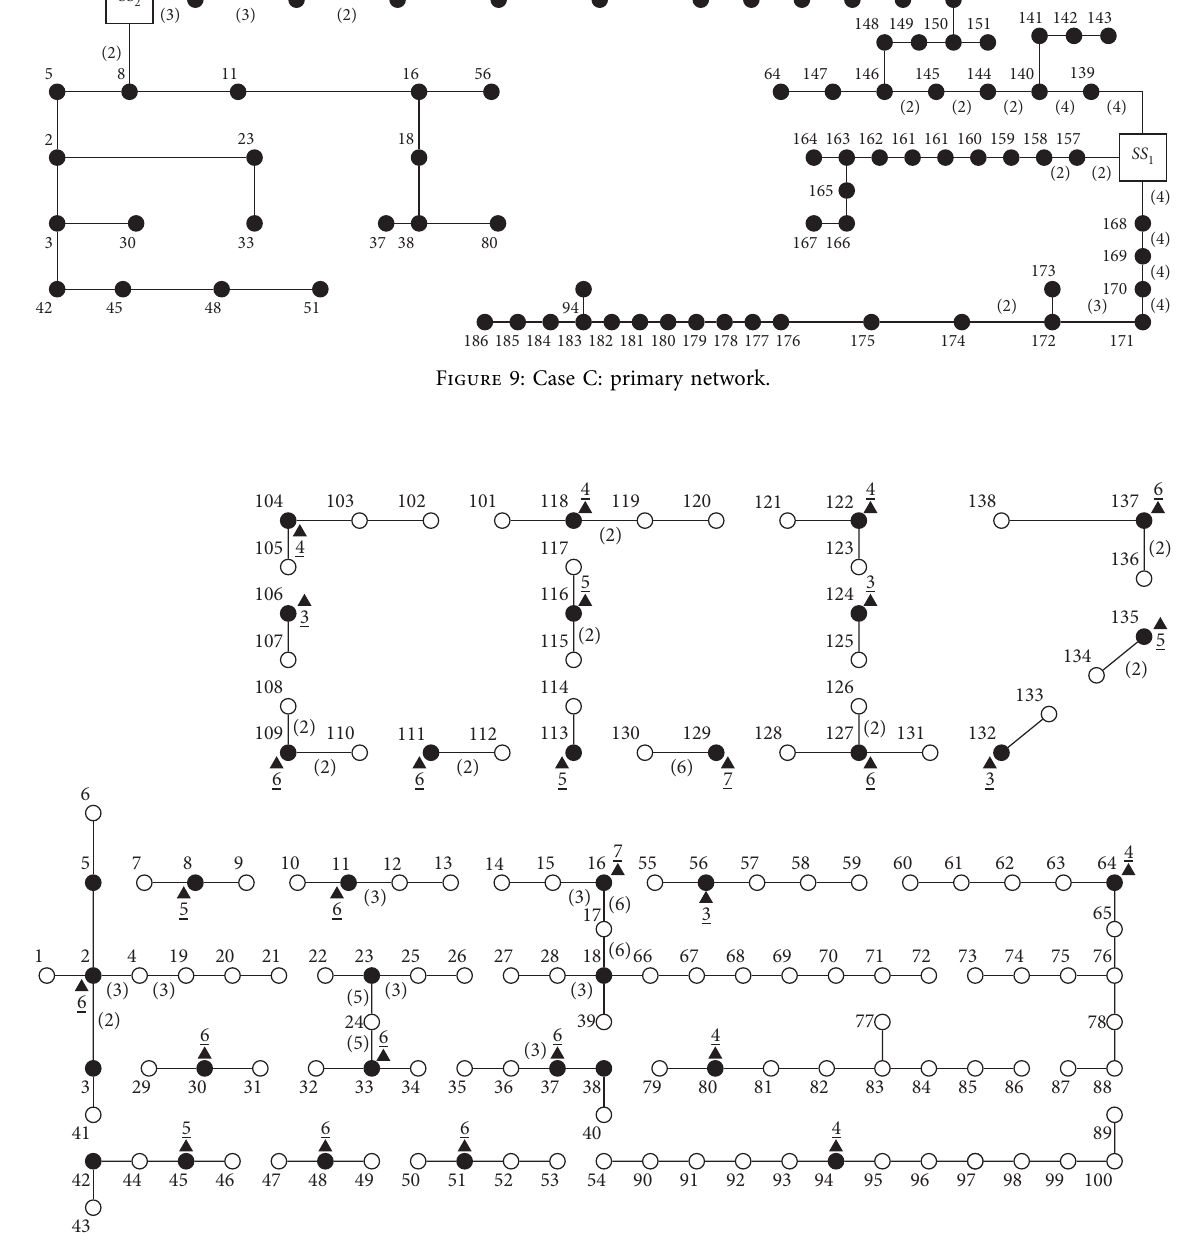
Figure 10: Case C: secondary